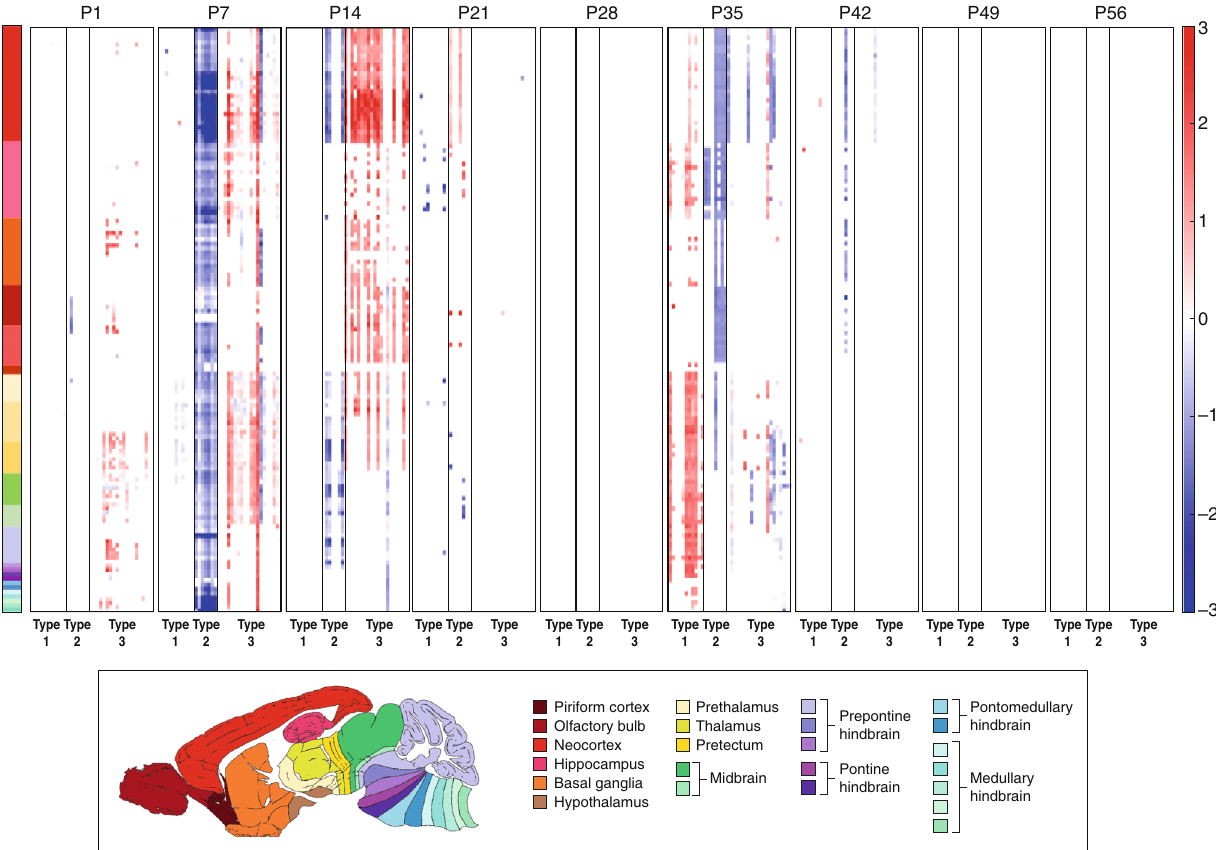
Signi fi cantly different ( P <0.05, Bayesian test, Benjamini – Hochberg corrected) subregions are shown and colored according to effect size (Cohen ’ s d scale bar). High-resolution graphs are provided in Fig.